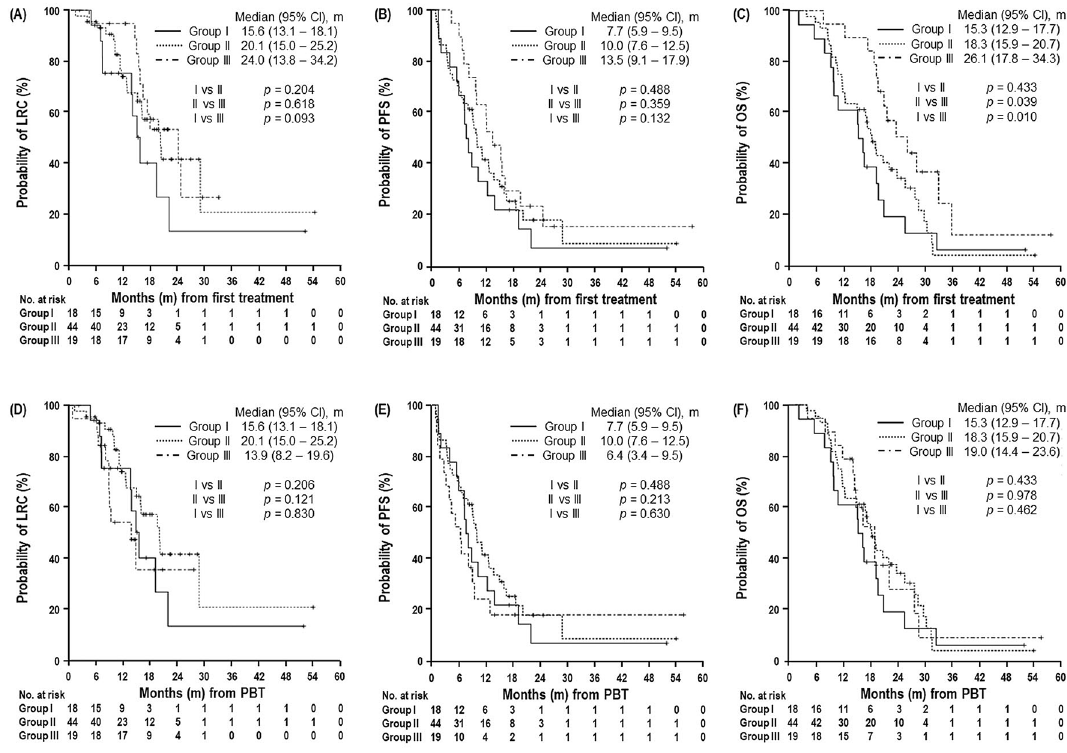
Figure 3. Locoregional control (LRC) ( A ), progression-free survival (PFS) ( B ), and overall survival (OS) ( C ) curves from initial treatment and LRC ( D ), PFS ( E ), and OS ( F ) from PBT.